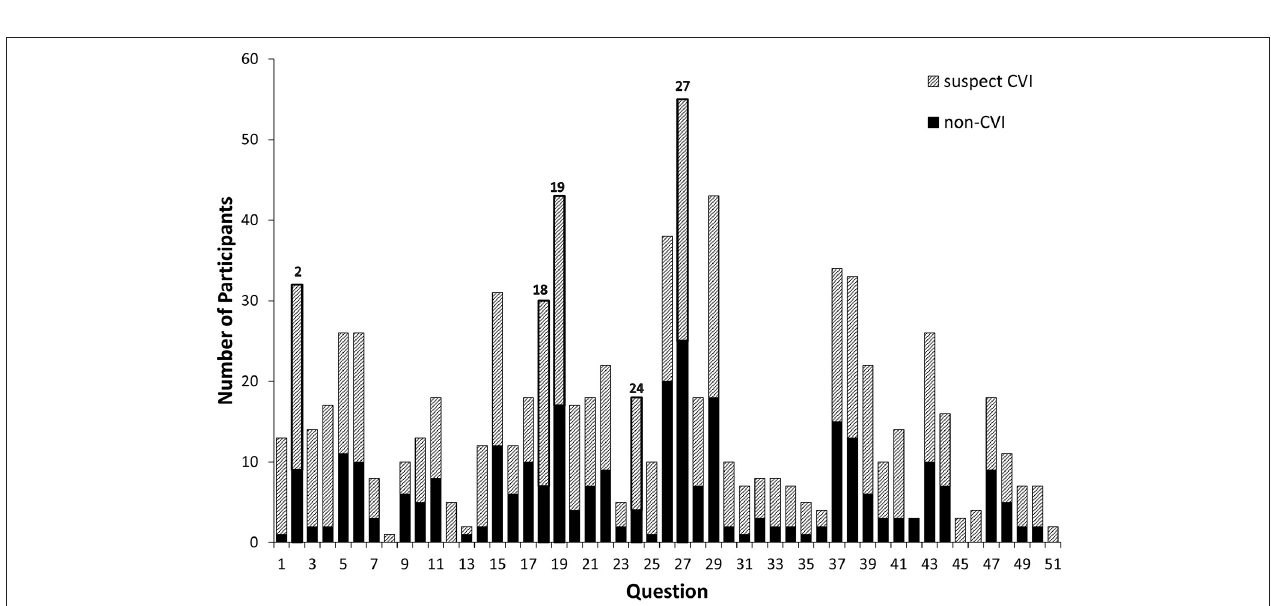
FIGURE 3 | The number of participants (81 in total) who responded positively to each question; crosshatching represents the participants who fitted the screening criteria for suspected CVI and solid fill represents the participants who did not. Questions 2, 18, 19, 24, and 27 are the diagnostic questions used in the CVI screening tool and are